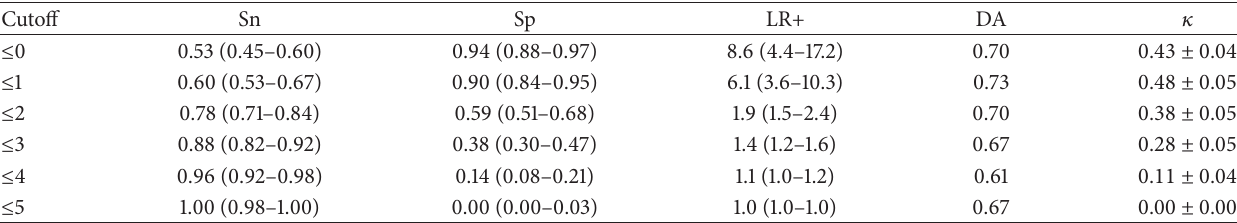
Table 3: Utility of the Mini-Cog for the detection of CI (MCI or dementia).